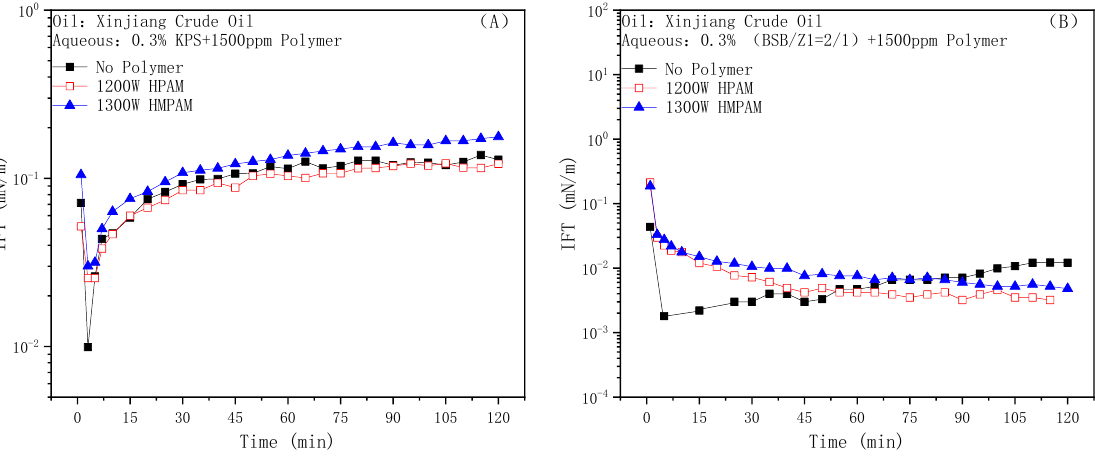
Figure 8. Effect of HPAM and HMPAM on the IFTs of the KPS ( A ) and BSB ( B ) solutions against Xinjing crude oil.